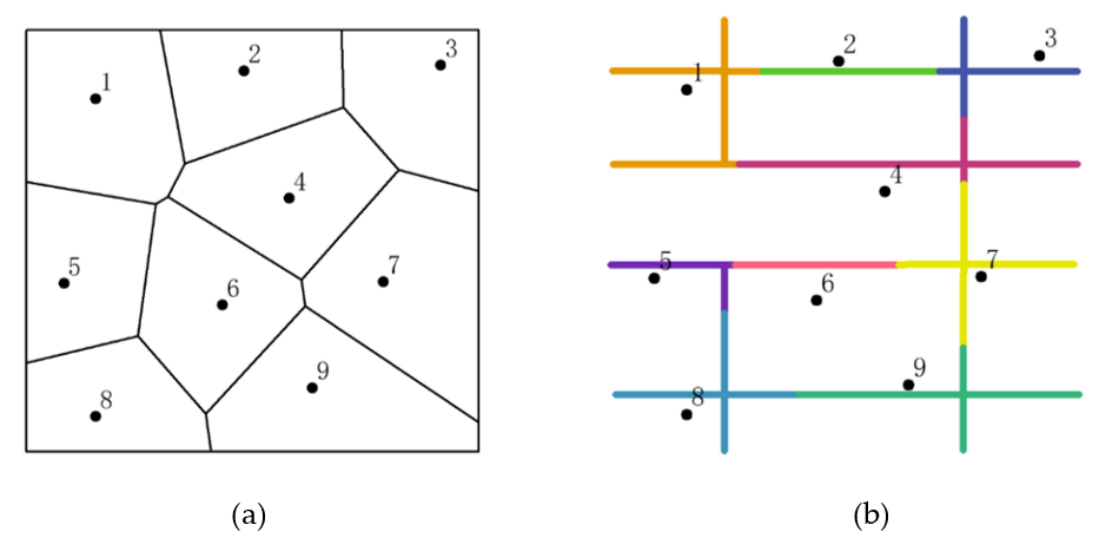
Figure 1. The comparison between two partitioning methods: ( a ) the traditional Voronoi diagram based on planar partitioning and ( b ) the street-based partitioning model.